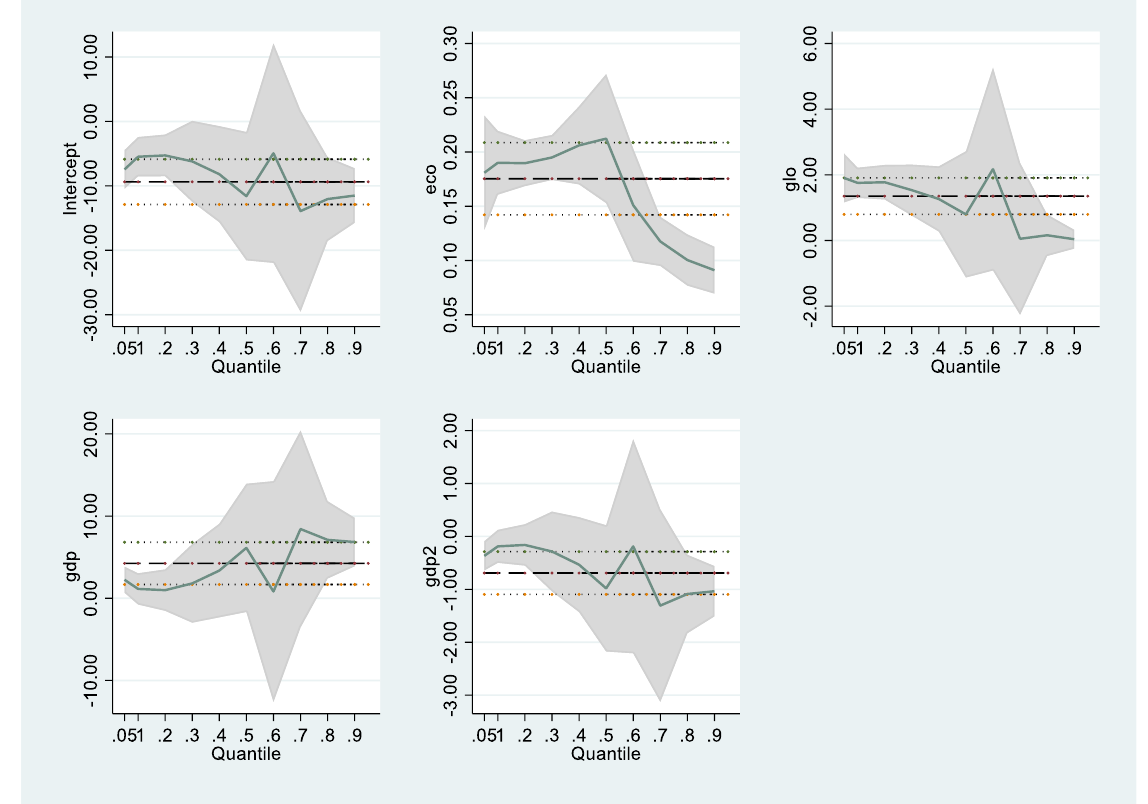
Figure 1. Variations in quantile